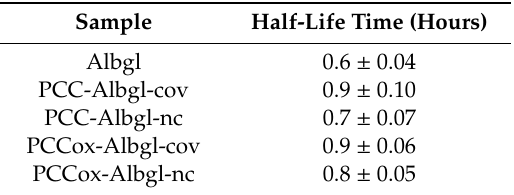
Table 4. Half-life time of free and immobilized Albgl on PCC and PCCox after incubation at 60 ◦ C in citrate phosphate bu ff er 100 mM pH 5.0.